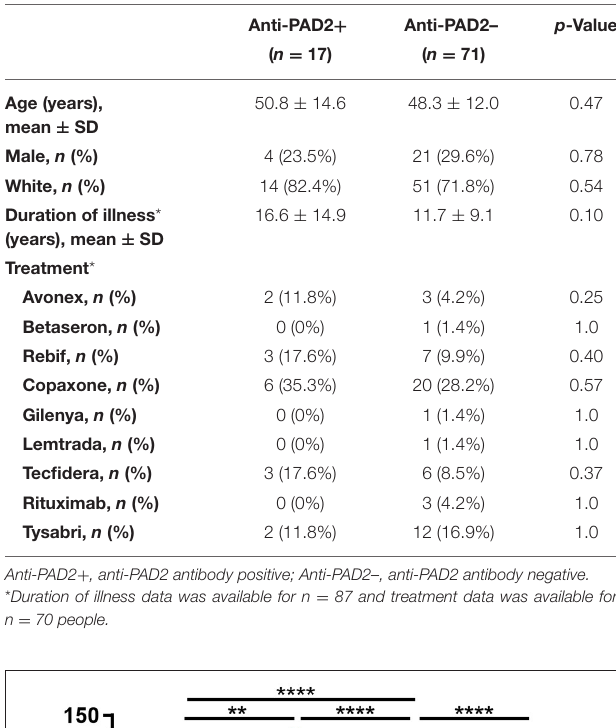
Figure 2 ]. Patients with NMO had significantly lower levels of anti-PAD2 antibodies [0.21 (0.15–0.46) anti-PAD2 AU] than and